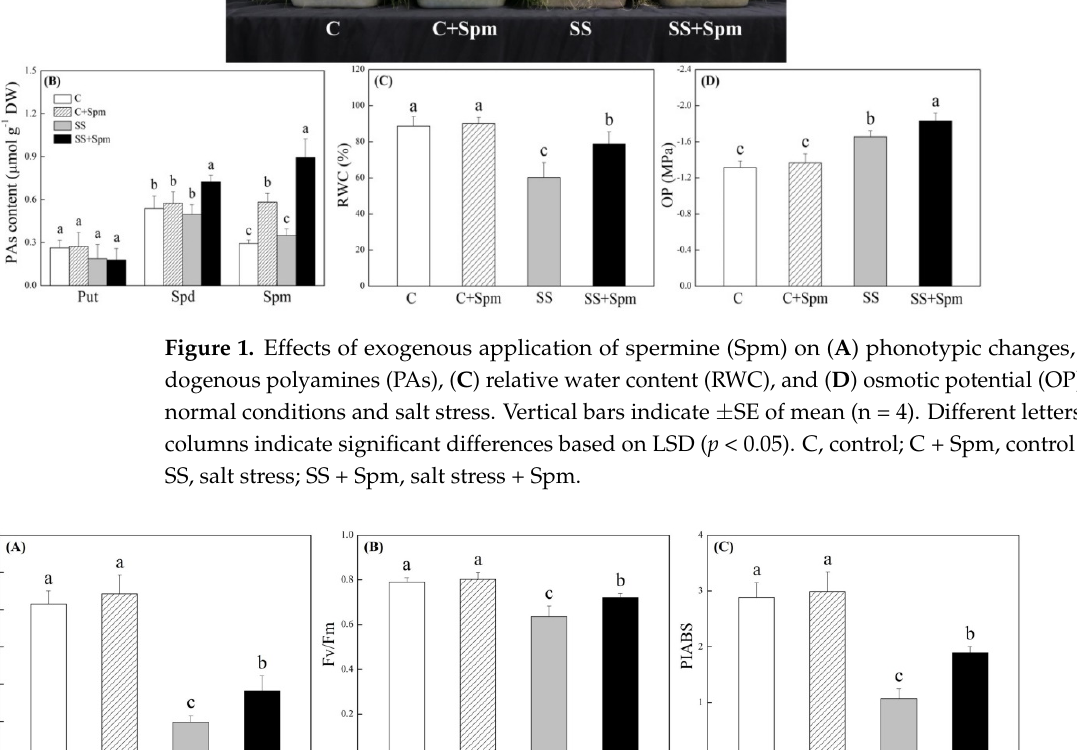
Figure 3. Effects of exogenous application of spermine (Spm) on ( A ) total antioxidant capacity (TAC), ( B ) hydroxyl radicals ( ∙ OH), ( C ) carbonyl content, and ( D ) electrolyte leakage (EL) under normal conditions and salt stress. Vertical bars indicate ±SE of mean (n = 4). Different letters above columns indicate significant differences based on LSD ( p < 0.05). C, control; C + Spm, control + Spm; SS, salt stress; SS + Spm, salt stress + Spm.